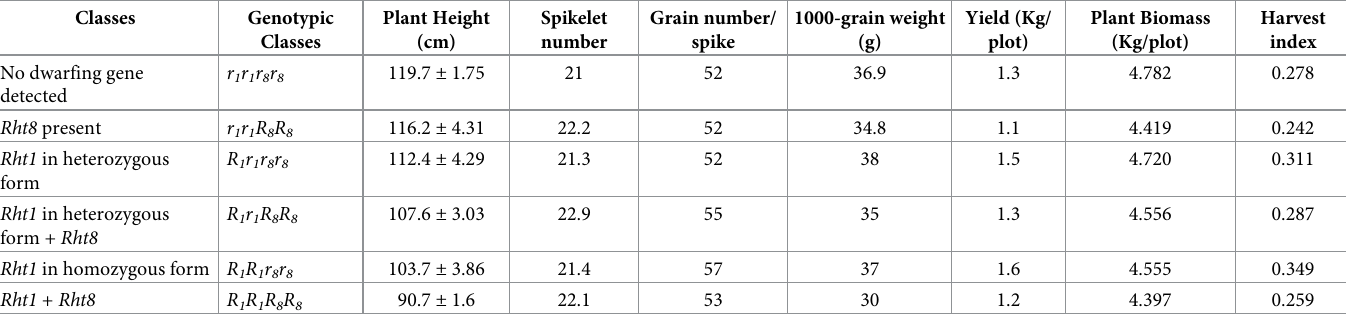
Table 2. Effect of Rht1 and Rht8 on different agronomic traits.